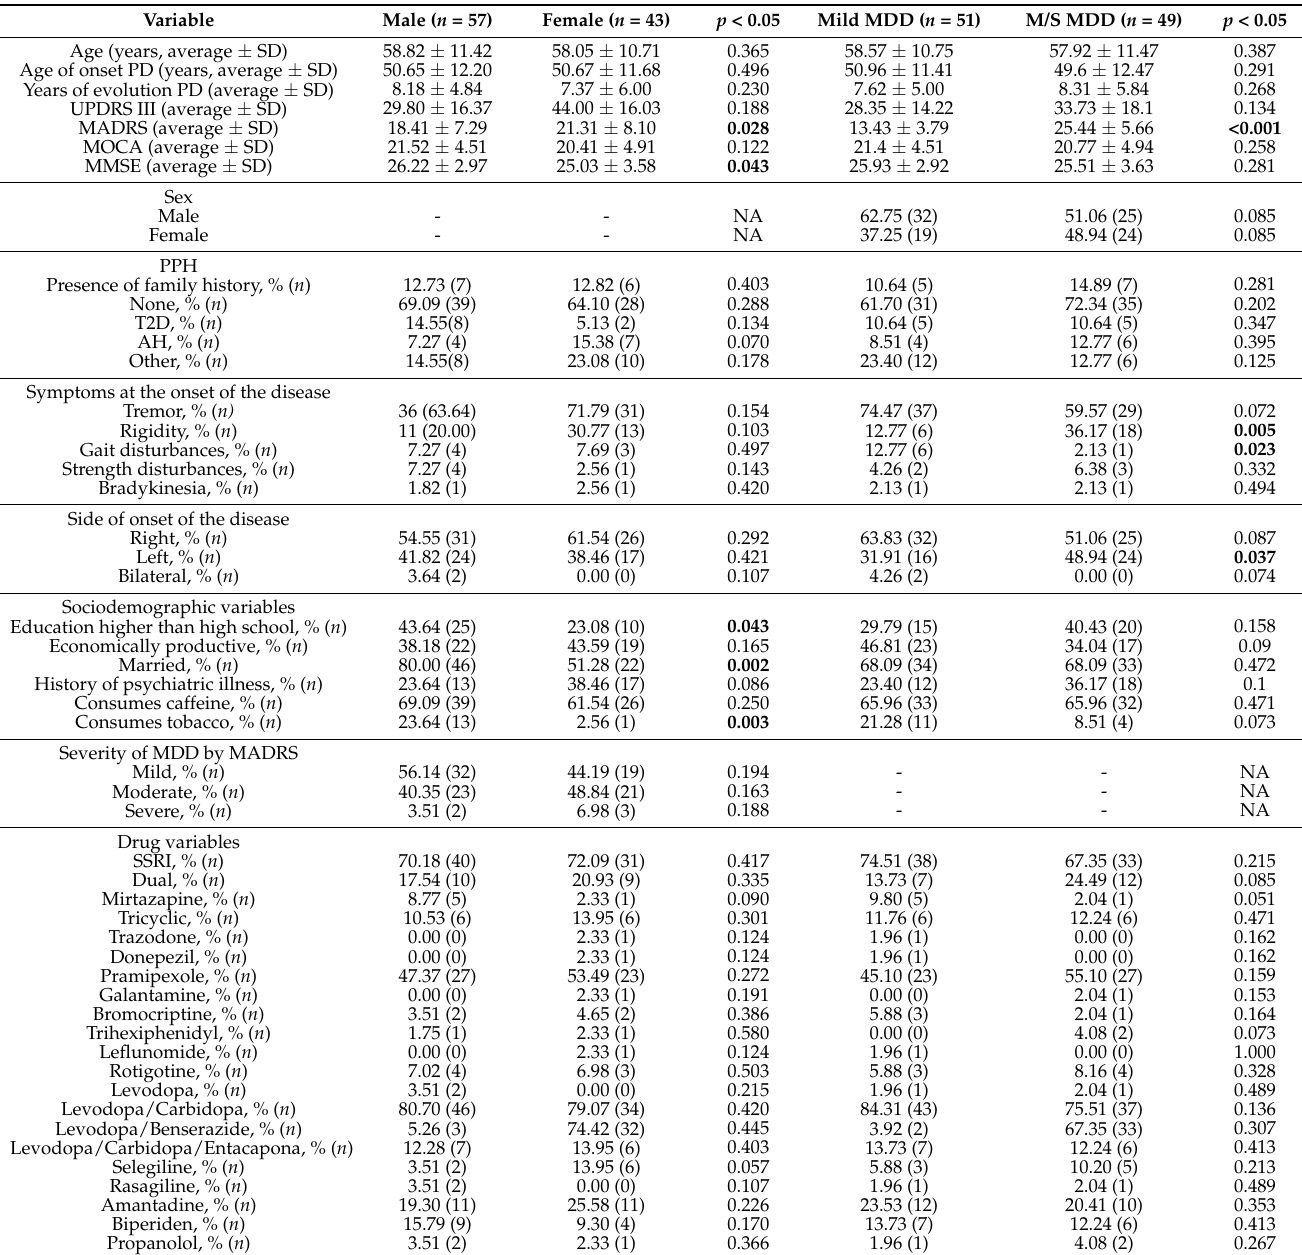
Table 3. Comparison between sexes and severity of MDD in general sample ( n = 100) of patients with PD and MDD (hypothesis